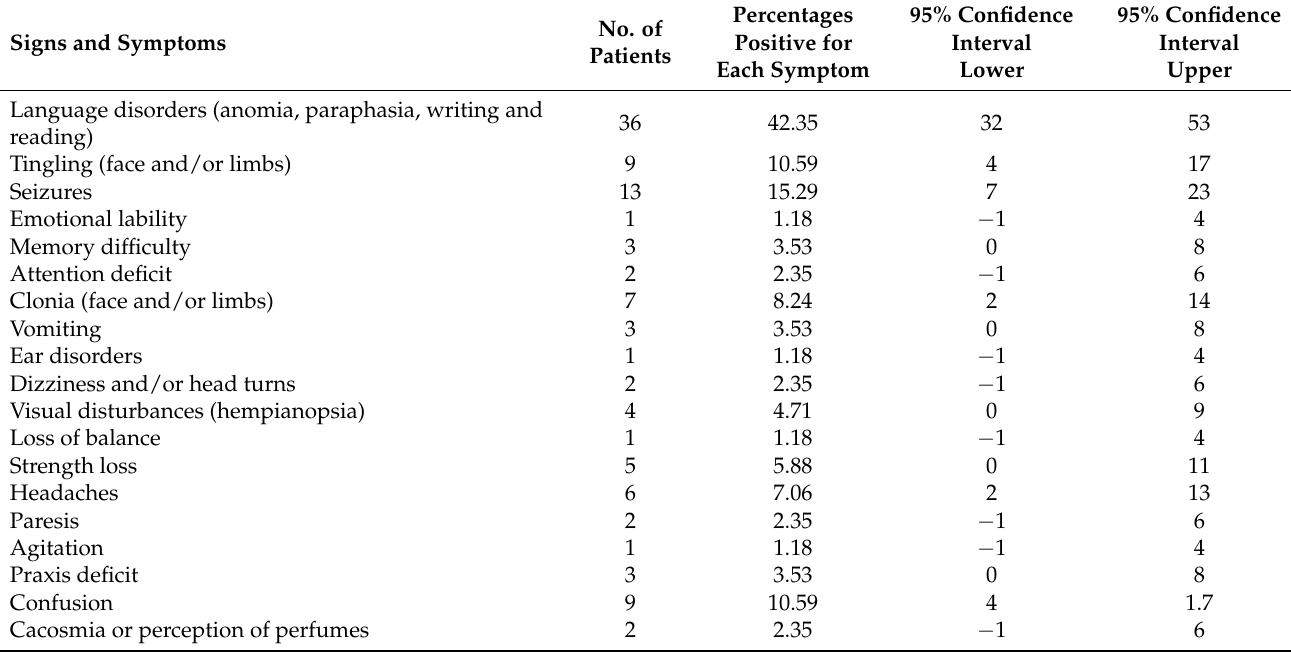
Table 2. Pre-surgery signs and symptoms.